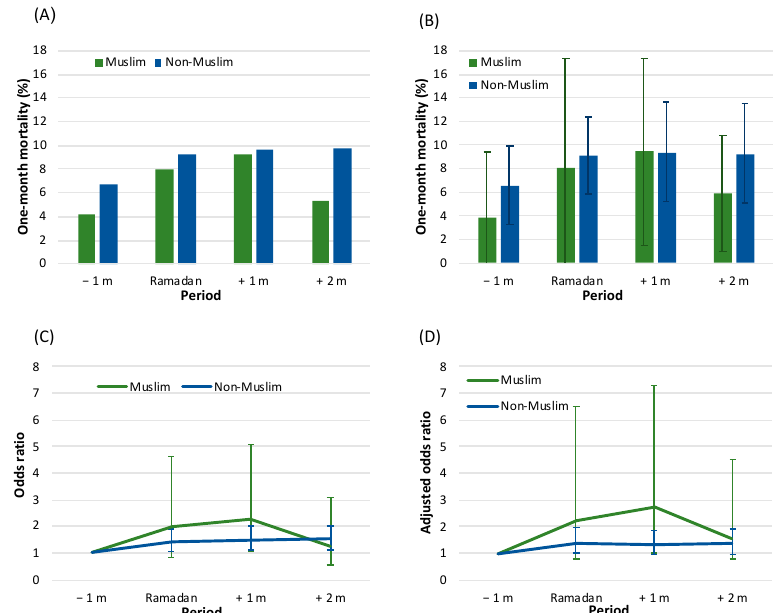
Figure 2. One-month mortality by study time period among Muslims and non-Muslims: ( A ) mortality rates (%), ( B ) annual mortality rates (mean and standard deviation), ( C ) unadjusted relative risk for mortality (odds ratio and 95% confidence interval (CI)), and ( D ) adjusted relative risk for mortality (adjusted odds ratio and 95% CI). Based on the results of the multivariate models (separately for Muslims and non-Muslims)—see Supplementary Table S3A,B. Legend: − 1m—month prior to Ramadan, Ramadan—month of Ramadan, +1m—one-month post-Ramadan, +2m—two-months post-Ramadan.